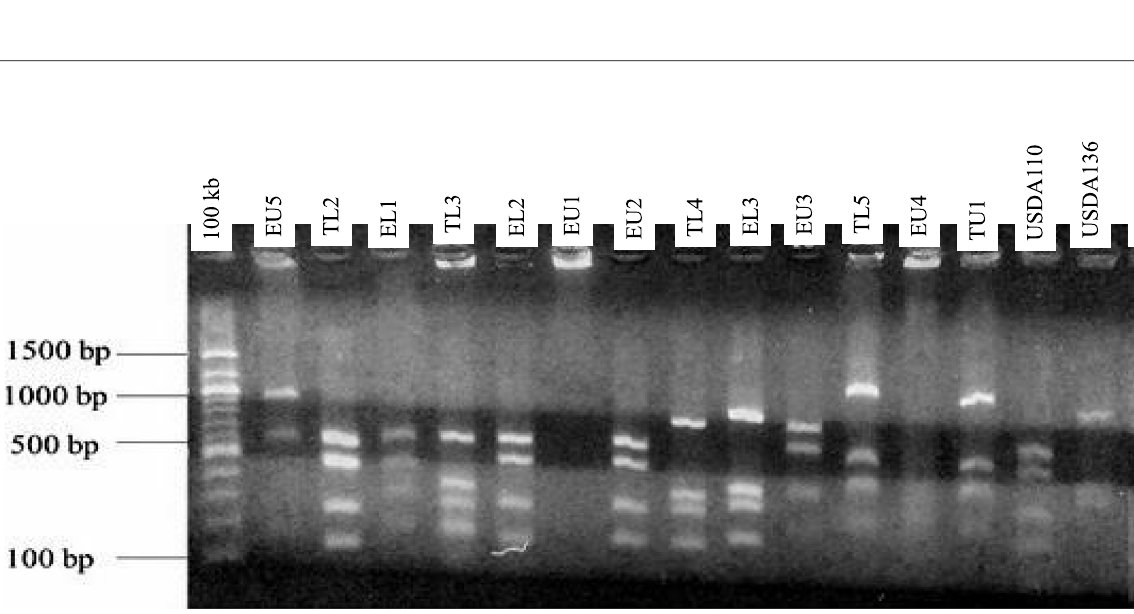
Fig. 2 Restriction fragments for rhizobia isolates obtained after digestion with the Msp I enzyme in 1.4% agarose gel where DNA was stained with SYBR